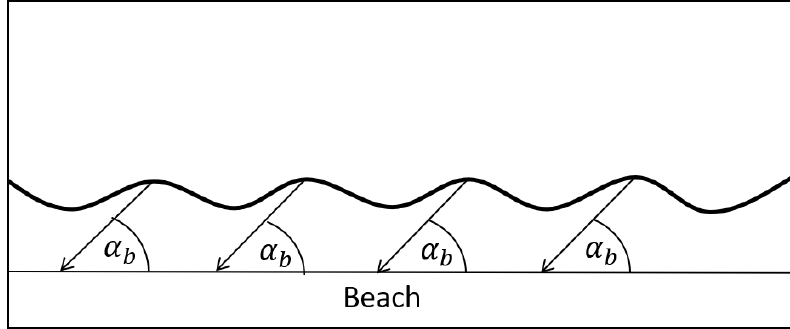
Figure 1. Breaking wave crests’ impact angle.